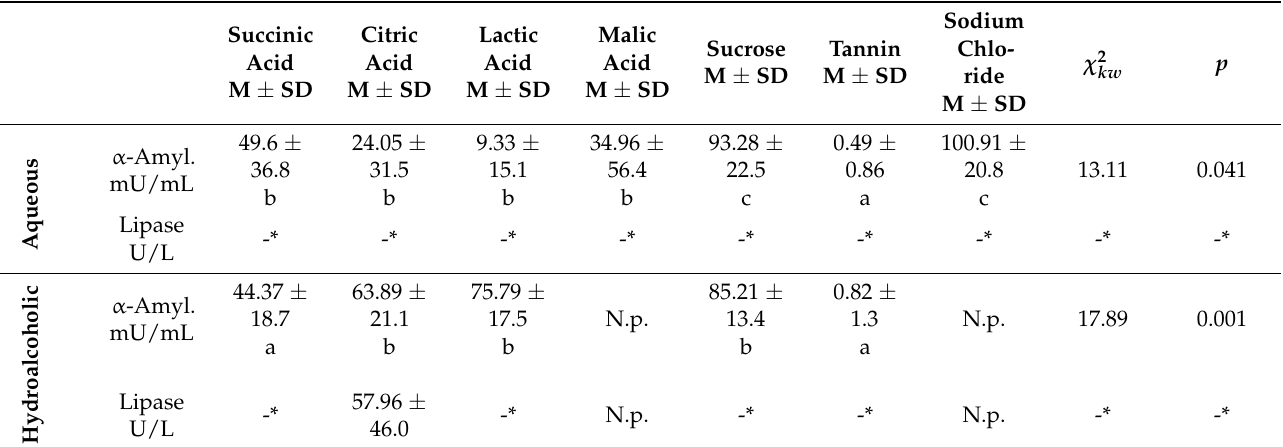
Table 3. Descriptive measurements and results of the Kruskal–Wallis test of enzymatic activity (lipase and α -amylase enzymes) in aqueous and hydroalcoholic solutions.